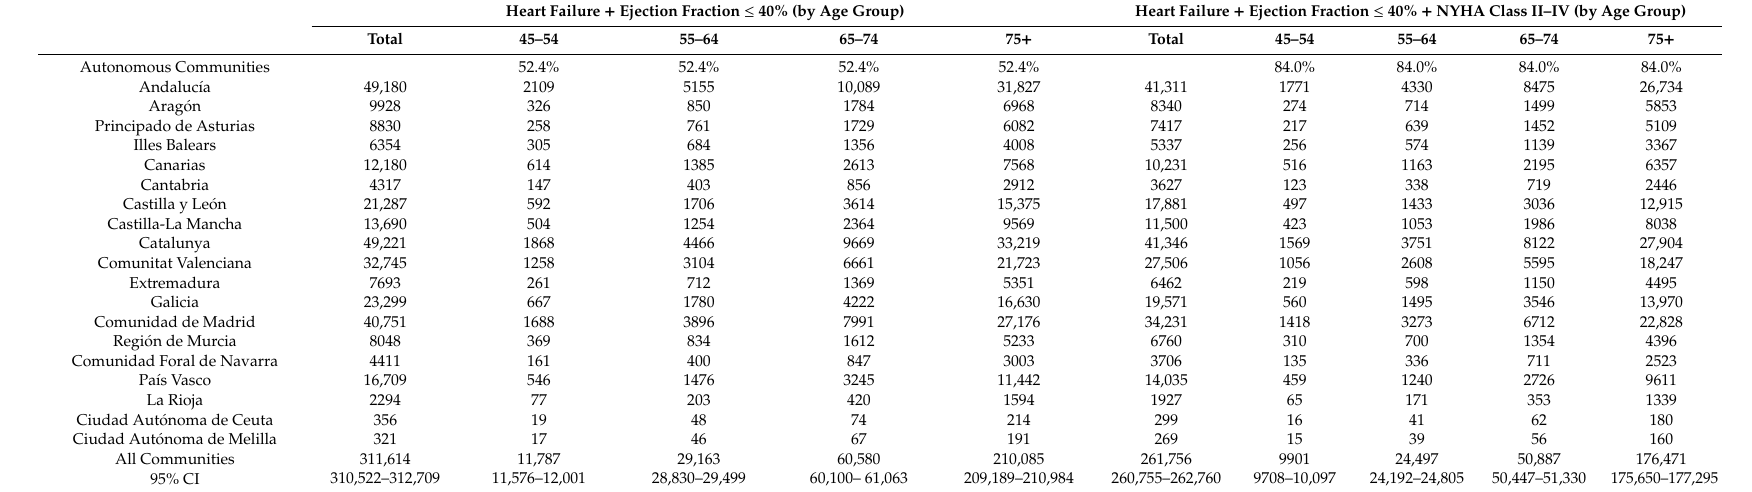
Table 5. Total number of patients in Spain and its autonomous communities with heart failure and ejection fraction ≤ 40%, as well as the number of heart failure patients with average ejection fraction ≤ 40% and in New York Heart Association functional class II–IV (based on data summarized in Table